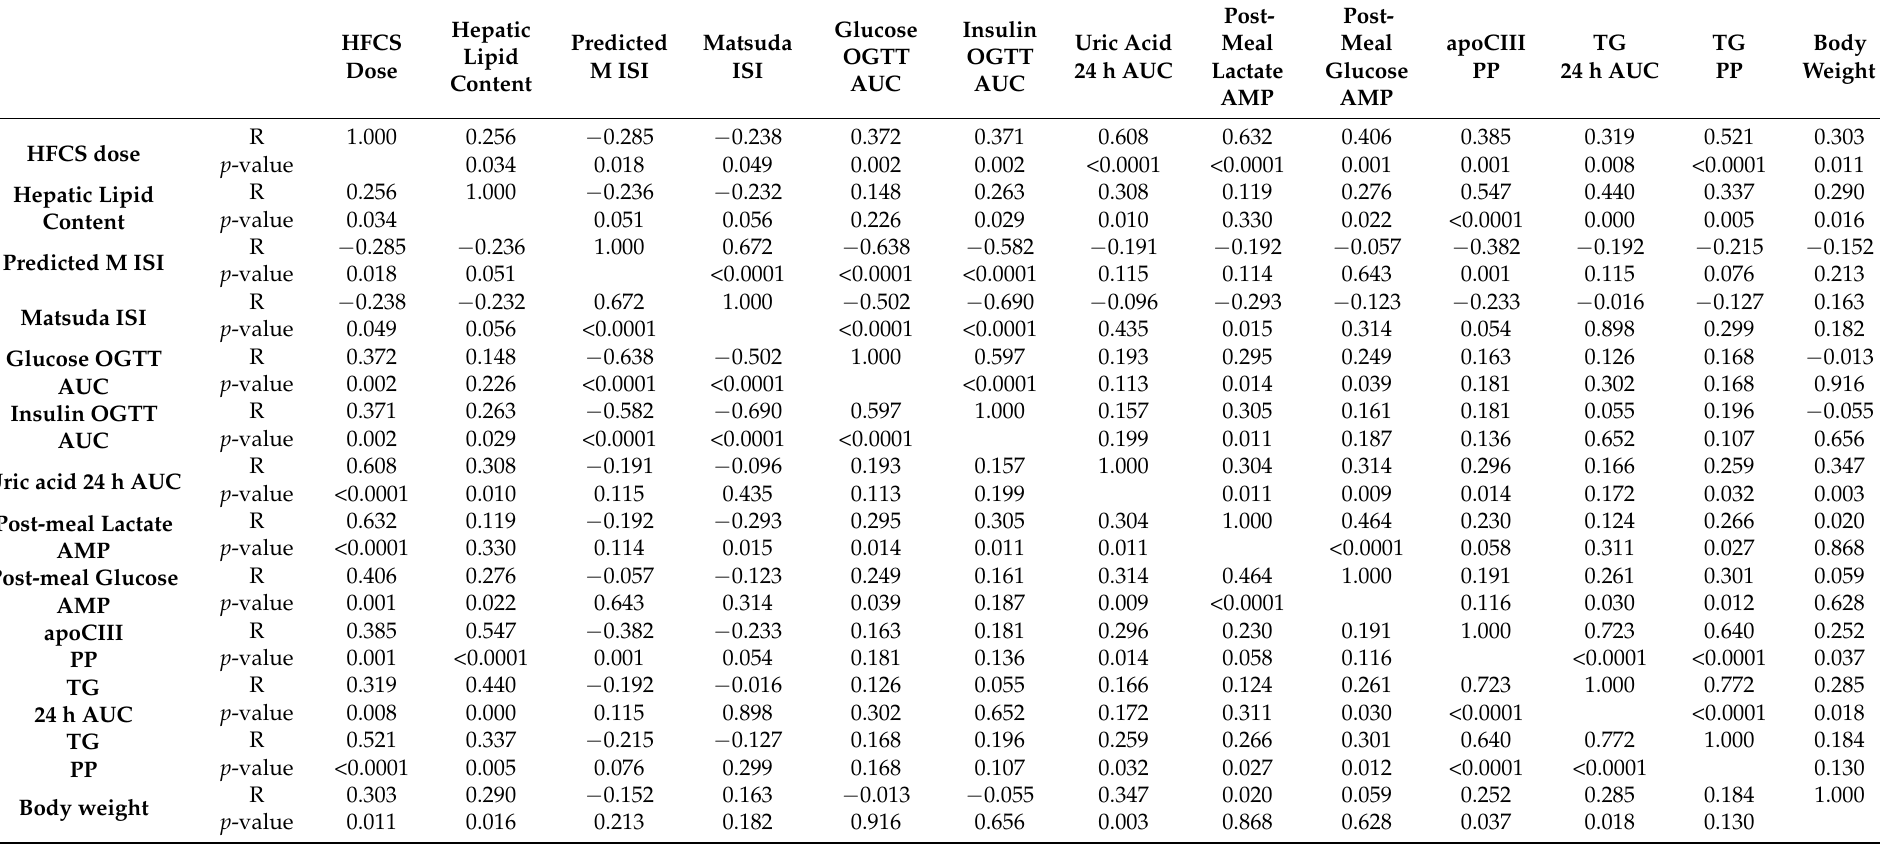
Table 3. The relationship between the absolute change of outcomes 1 significantly affected by dose 2